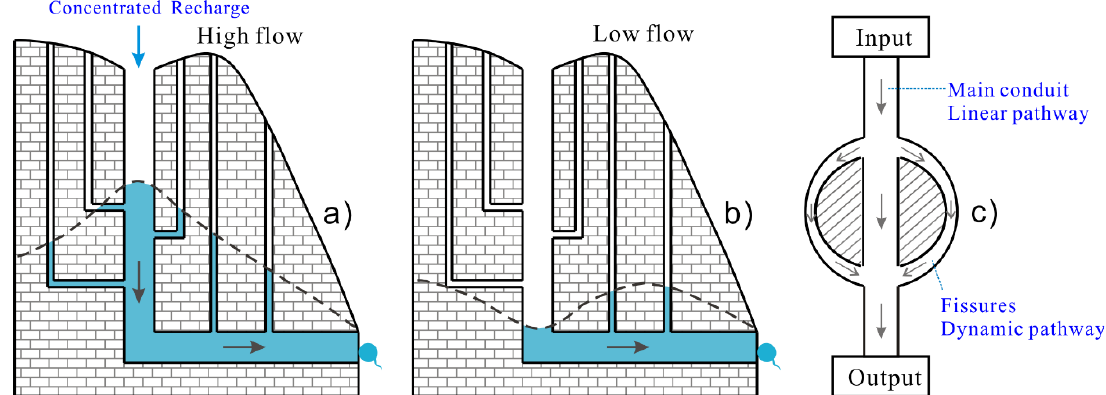
Figure 2. Conceptual sketch of the two solute transport paths in the karst conduit-fissure system under concentrated recharge condition. ( a ) Water level in the conduit is higher than that in the fissure, that conduit flow infiltrates into the fissure flow. ( b ) Water level in the conduit is lower than that in the fissure, that conduit flow gets recharge from fissure flow. ( c ) Two conceptual solute transport paths that shows longer flow path through the fissures .